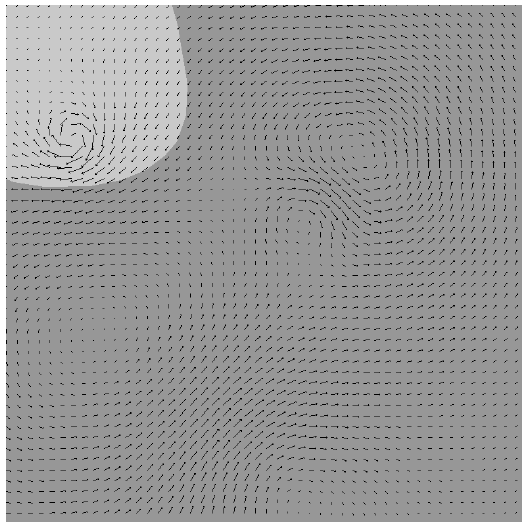
Figure 3. The Lamb vortex diagram.